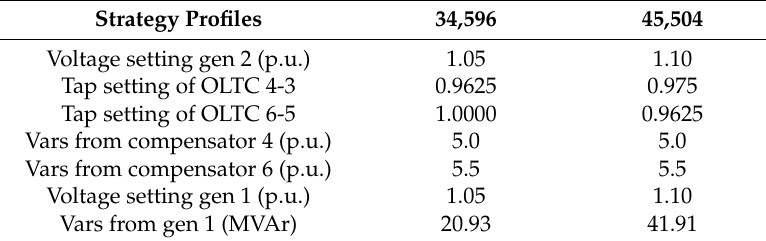
Table 1. Equilibrium component